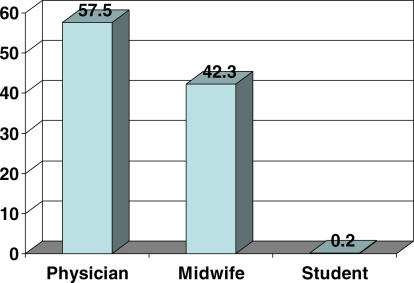
The Percentage of Deliveries Attended by a Physician, Midwife, or Student